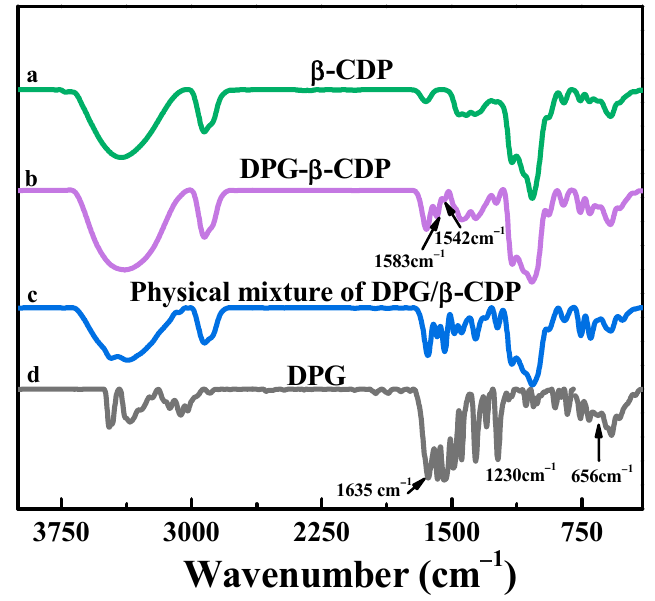
Figure 2. FT-IR spectra of DPG- β -CDP and comparison with other substances.